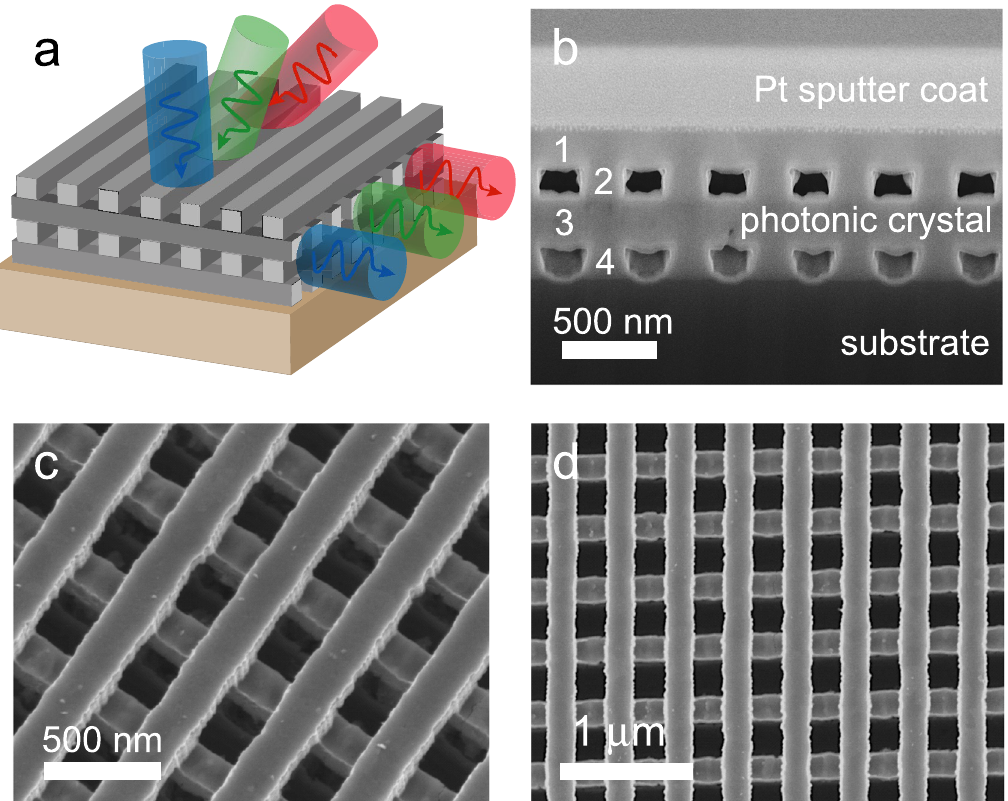
Figure 1. Schematic of a TiO 2 simple cubic photonic crystal. ( a ) Schematic of TiO 2 PC depicting parallel-to- interface refraction. ( b ) Cross-section side view ( c ) perspective view and ( d ) top view of fabricated TiO 2